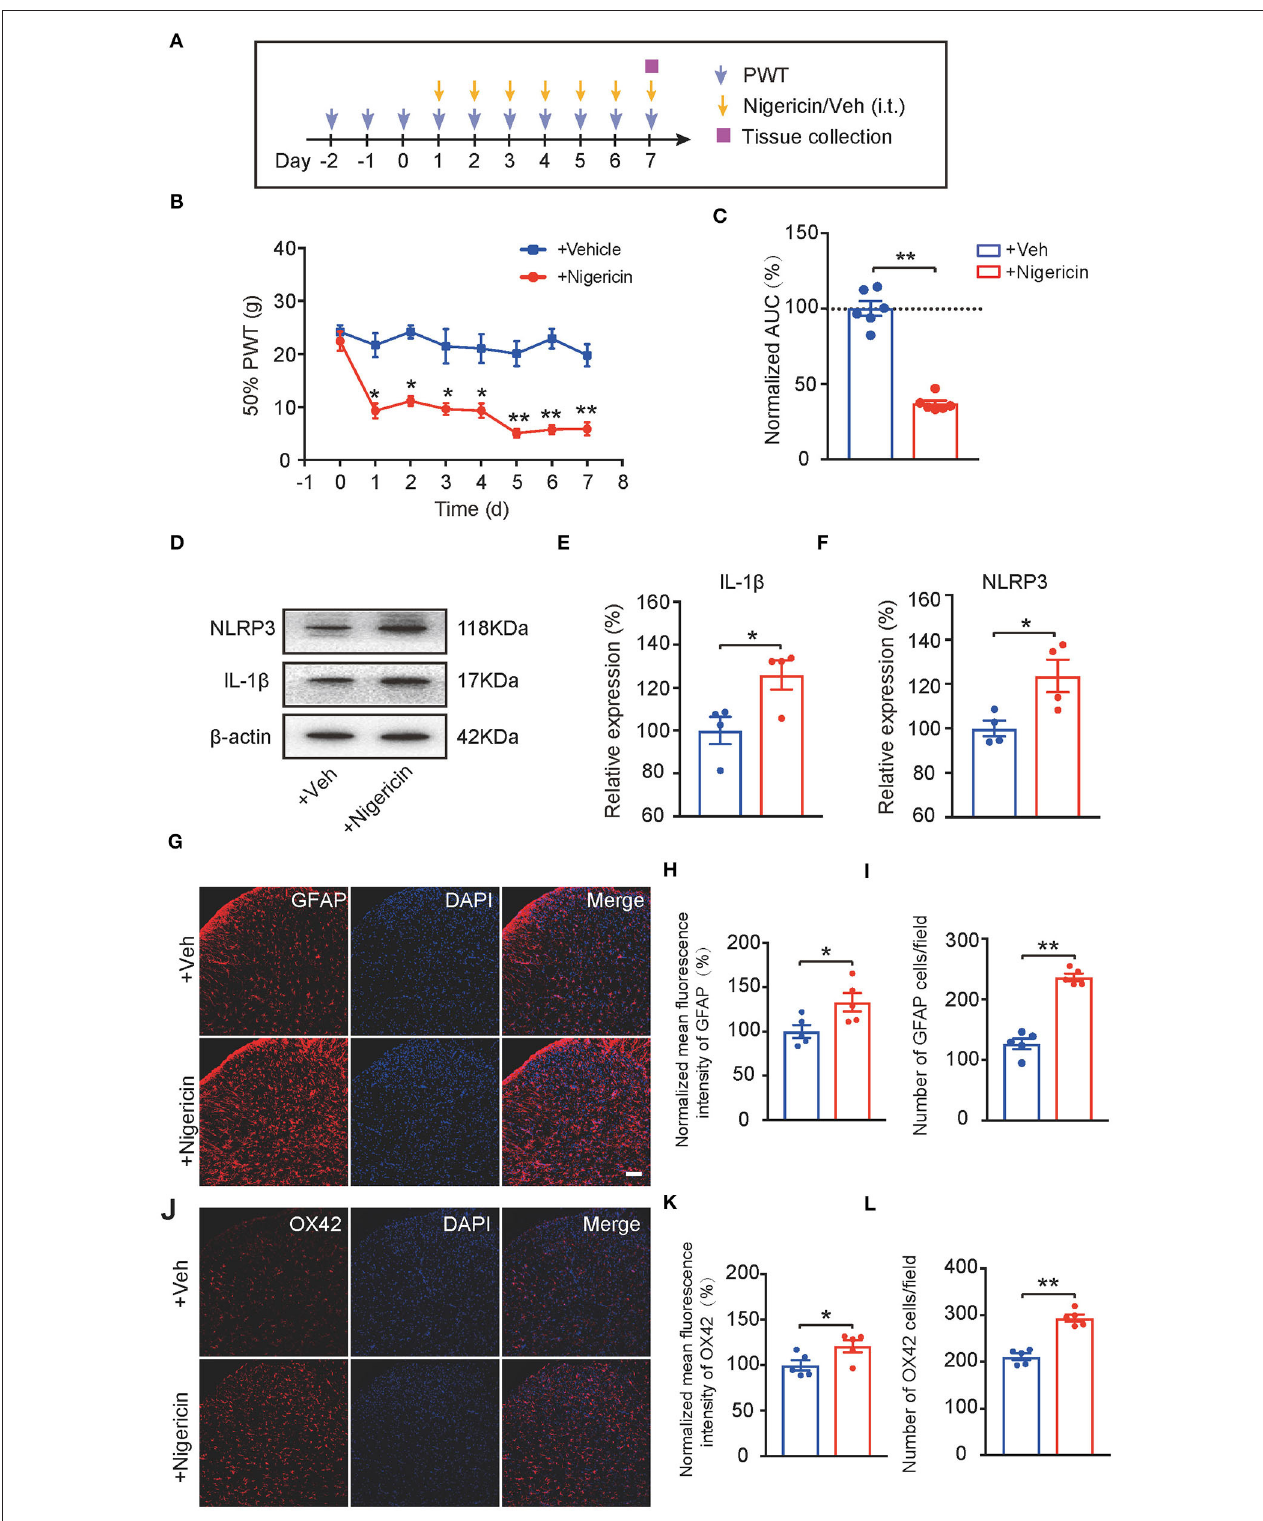
FIGURE 7 | NLRP3 inflammasome activation per se causes mechanical allodynia and spinal glial activation in naïve animals. (A) Experimental protocol indicating treatment time points. (B) 50% PWT of rats after intrathecal vehicle (0.1% ethanol in PBS) or nigericin (5 µ g/rat/day) injection. (C) Normalized AUC deduced from (B)